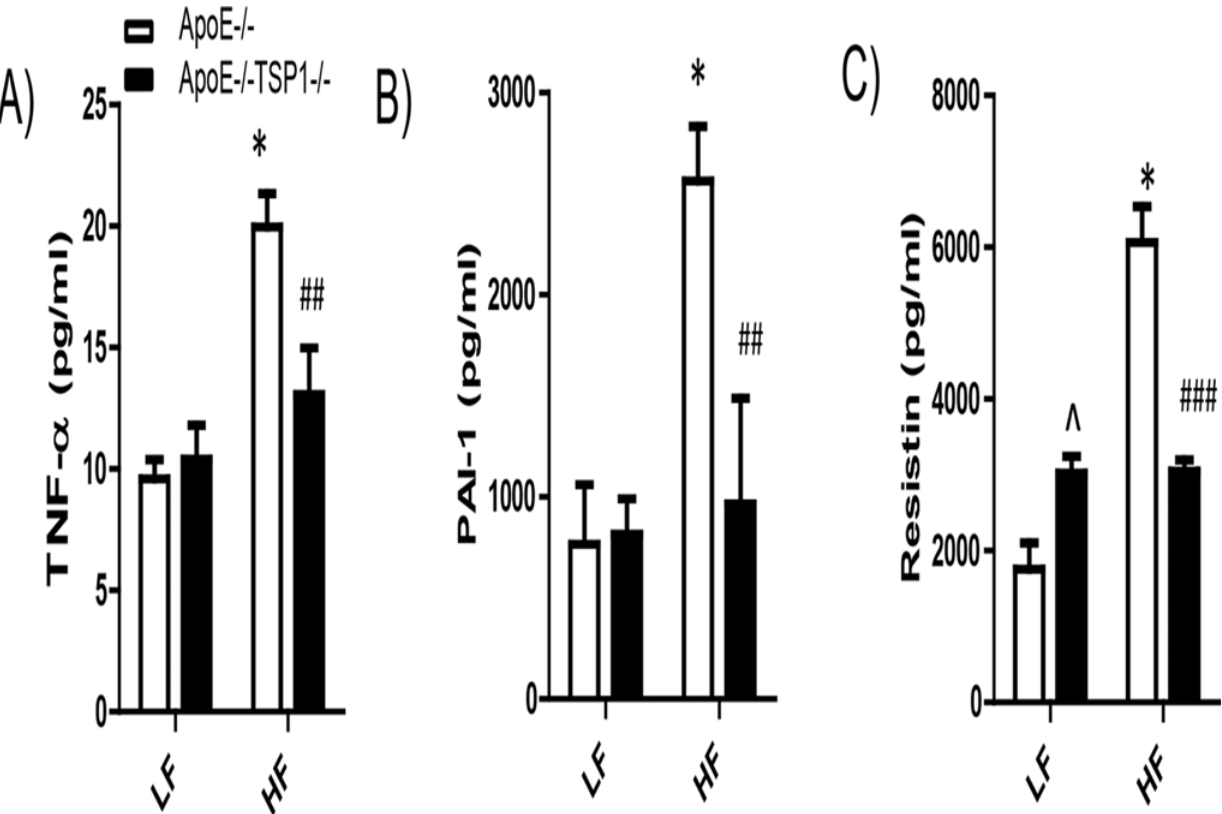
Fig 3. Obesity induced systemic inflammation was reduced in ApoE-/-TSP1-/- mice. Plasma TNF- α , PAI-1 and resistin levels were measured as described in Material and Methods section. Data are represented as mean ± SE (n = 6 mice/group). ^ P < 0.05 vs. LF ApoE-/-; * P < 0.05 vs. LF ApoE-/-; ## P < 0.01 or ### P < 0.001 vs. HF